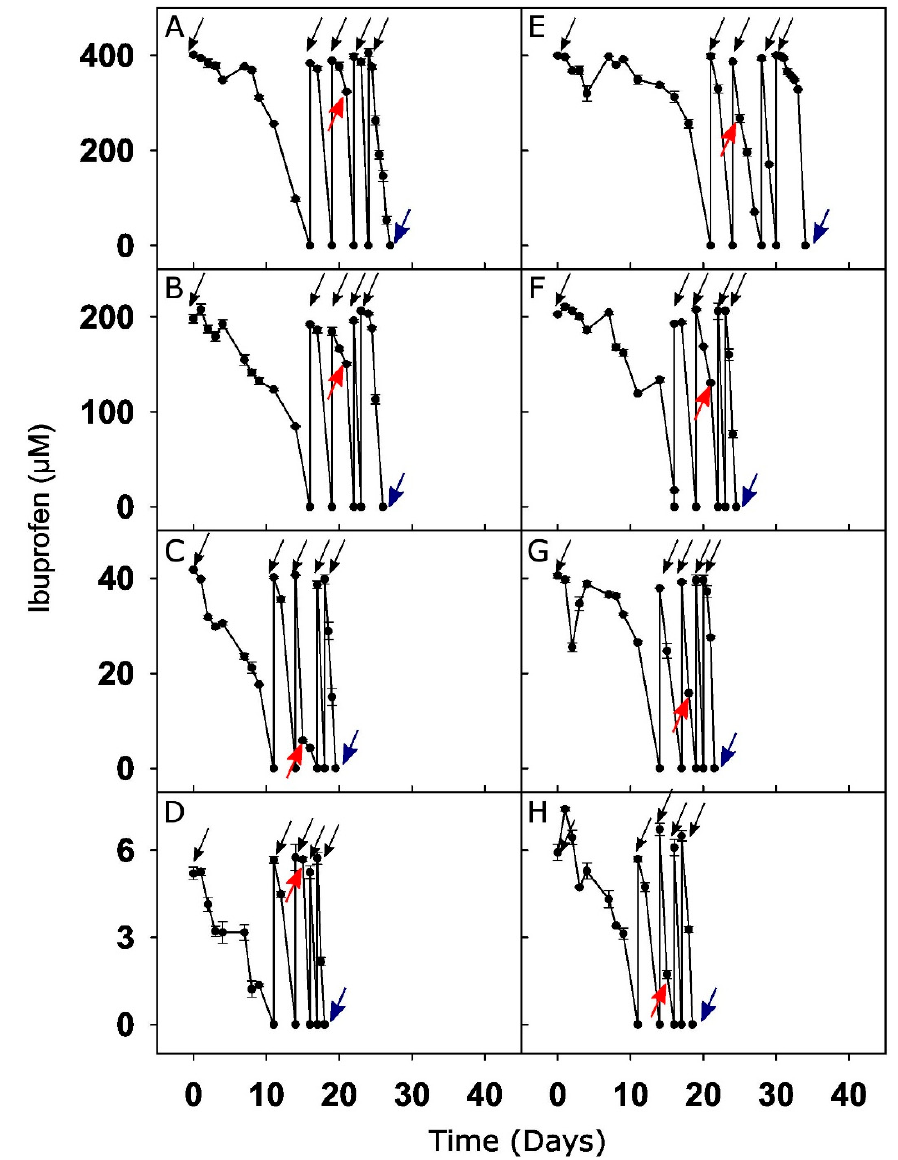
Figure 1. Degradation of ibuprofen in oxic hyporheic zone sediment microcosms. Plots ( A – D ) correspond to sediment amended with ibuprofen concentrations of 5, 40, 200, and 400 µM, respectively. Plots ( E – H ) correspond to sediment amended with both 1 mM acetate and ibuprofen concentrations of 5, 40, 200, and 400 µM, respectively. Values are the arithmetic means of triplicate oxic incubations. Error bars indicate standard deviations. Some standard deviations are smaller than the symbol size and therefore not apparent. Arrows indicate the time of refeeding of microcosms with ibuprofen ( A – D ) and acetate and ibuprofen ( E – H ), respectively. Red and blue arrows indicate sampling of the sediment for nucleic acid extraction after the third and fifth refeeding, respectively.